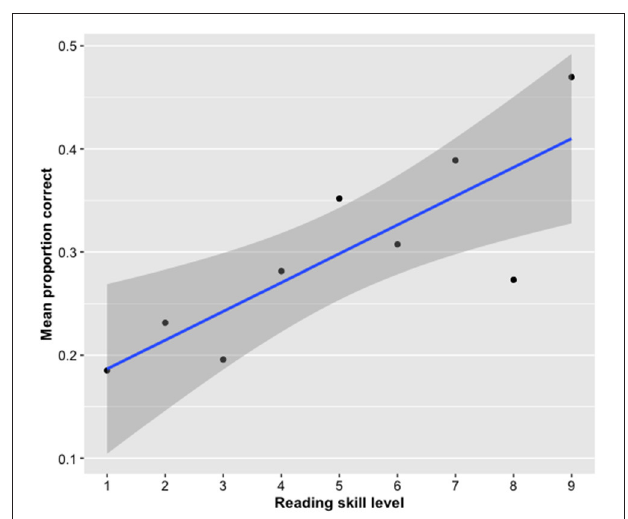
FIGURE 7 | Effect of reading skill level on accuracy in the post-tests. Skilled readers remembered more words than less skilled readers. The dots represent the average proportion of words remembered for all the children within a given level of reading skill. The shaded area represents the 95% confidence